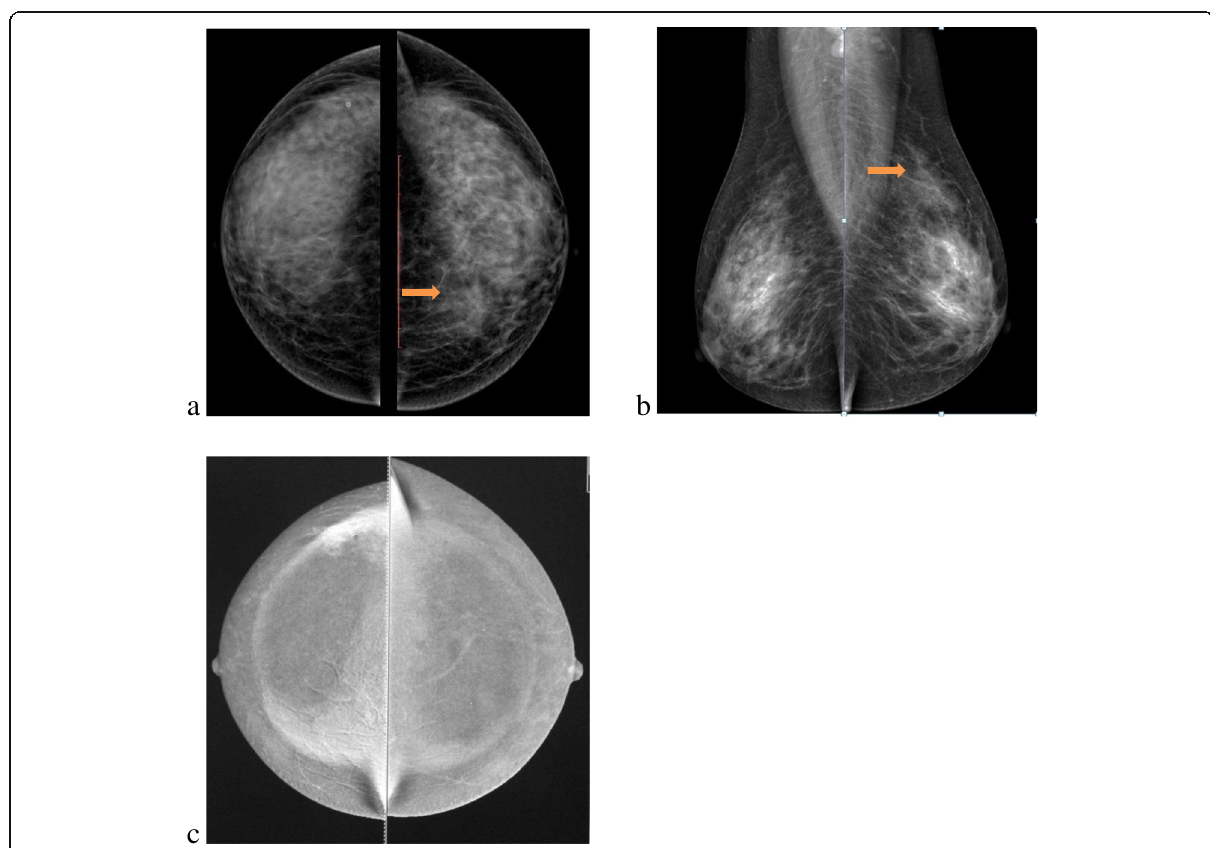
Fig. 6 A case presented with palpable lump at upper inner quadrant showing left focal asymmetry in CC ( a ) and MLO ( b ) views. US showed condensed glandular tissue. CEDM was requested by patient for reassurance and showed no enhancement in recombined image ( c ). Patient was reassured and recommended for routine follow-up